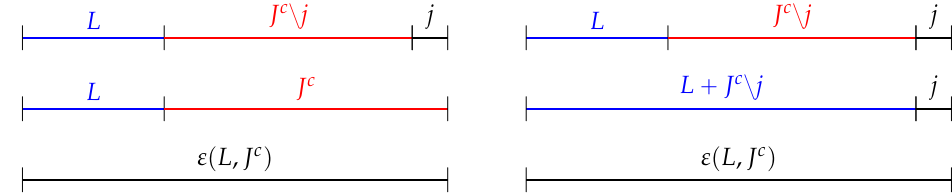
Figure 2. Visual aid for the identity σ p J c z j , j q σ p L , J c q “ σ p L , J c z j q σ p J c z j ` L , j q .